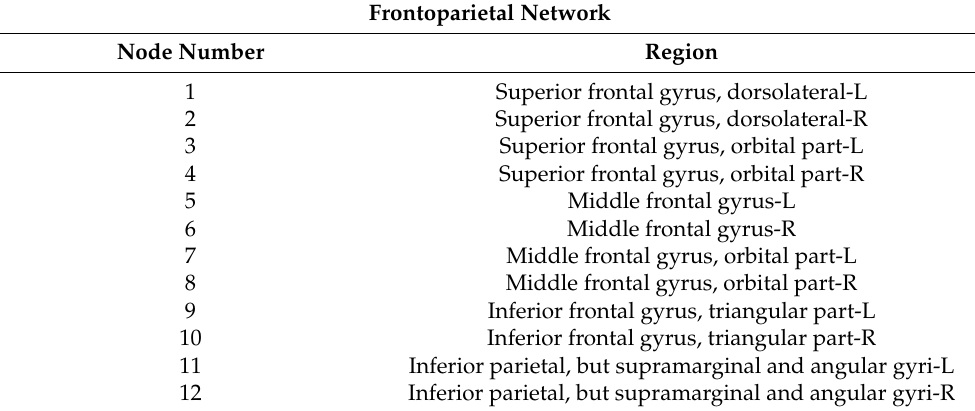
Table 2. ROIs of the FPN corresponding to the activity pattern in Figure 1a,b.